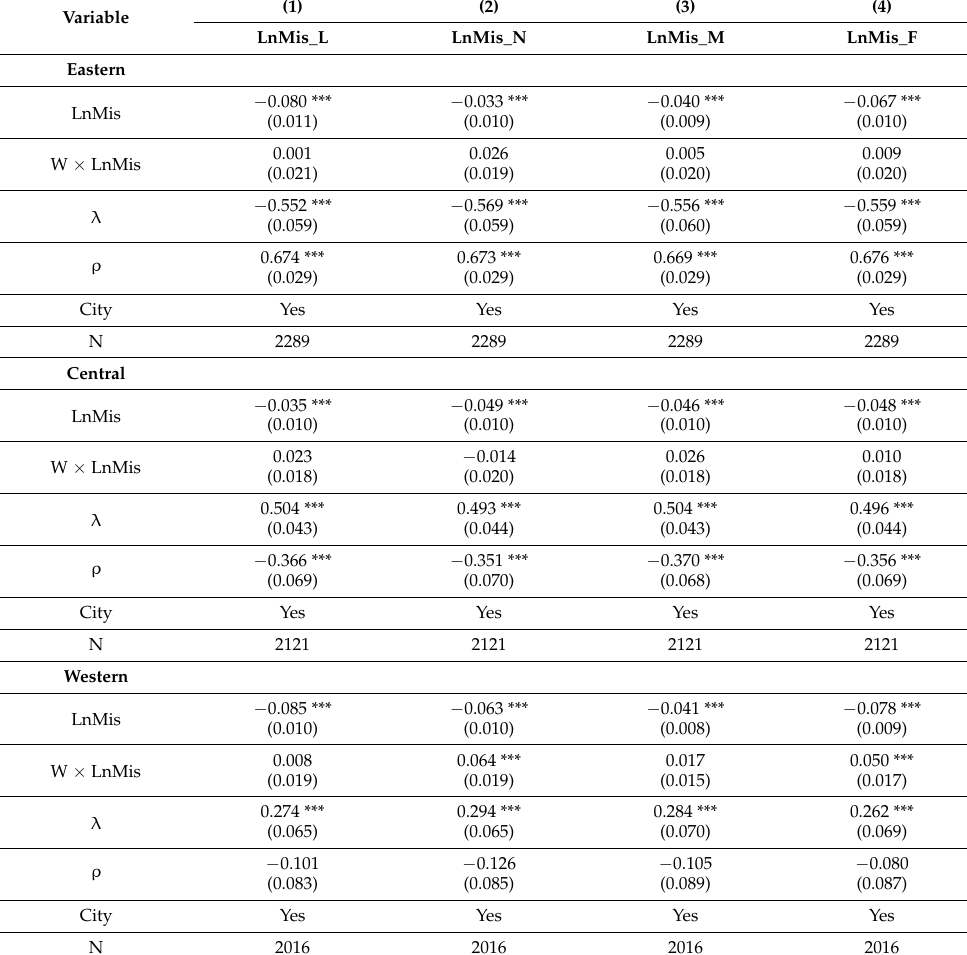
Table 11. Heterogeneity test results.